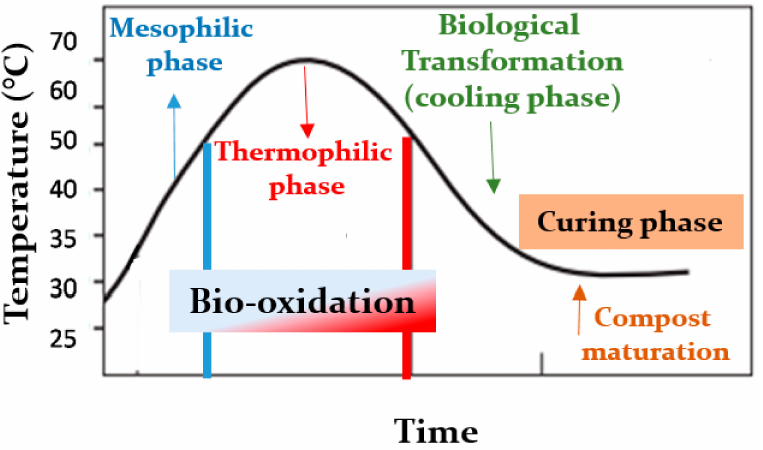
Figure 1. Temperature changes in the composting